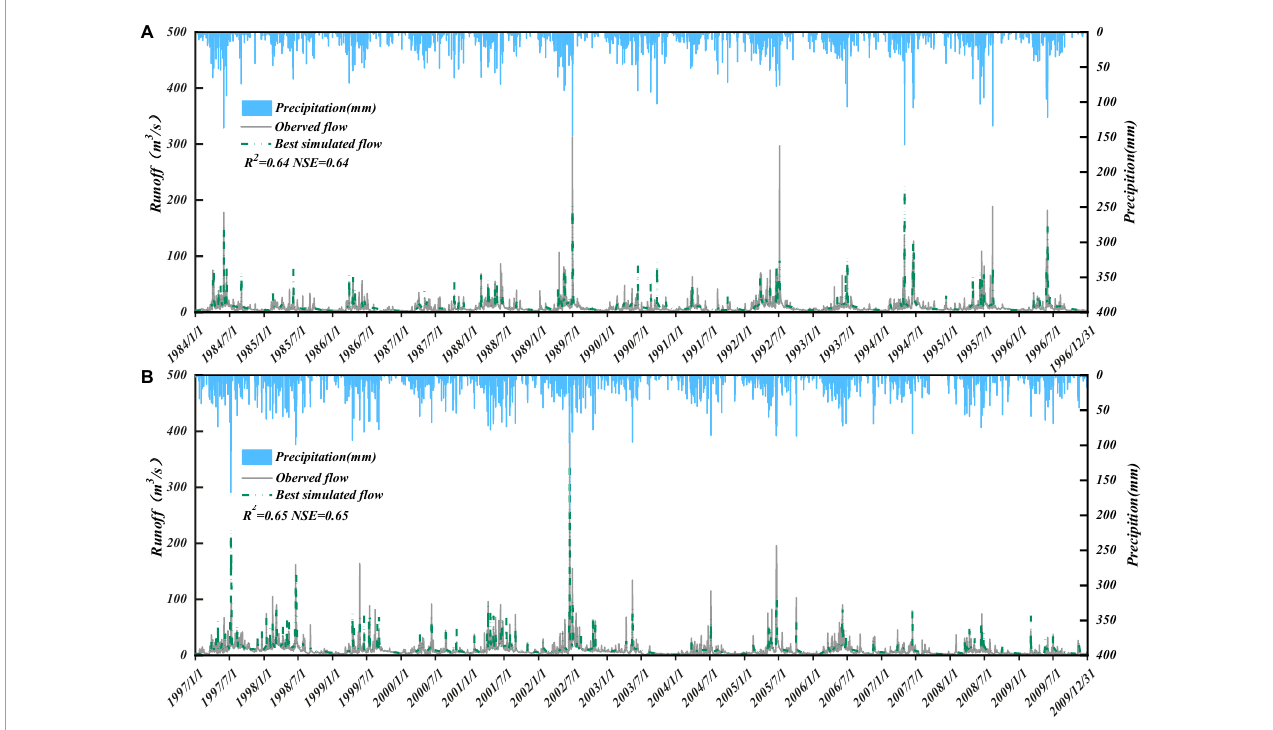
FIGURE7 The Shuangtian hydrological station’s calibration period (A) and validation period (B) time series of simulated and observed data.